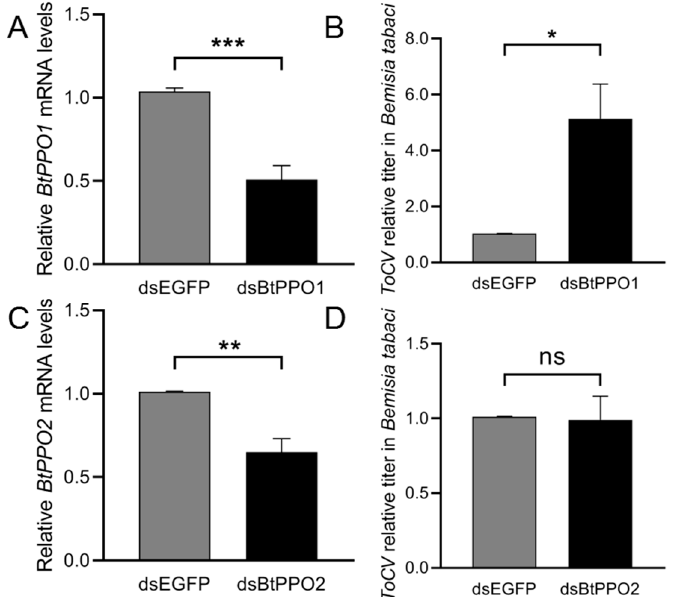
Figure 6. Efficiency of RNA interference and ToCV titer in Bemisia tabaci after RNA interference. ( A ) Relative mRNA levels of BtPPO1 in B. tabaci adults after feeding on a diet containing dsEGFP and dsBtPPO1. ( B ) Effect of BtPPO1 gene silencing on ToCV titer in B. tabaci . Data of ( A , B ) presented as the mean ± SE for nine independent replicates. ( C ) Relative mRNA levels of BtPPO2 in B. tabaci adults after feeding on a diet containing dsEGFP and dsBtPPO2. ( D ) Effect of BtPPO2 gene silencing on ToCV titer in B. tabaci . Data of ( C , D ) presented as the mean ± SE for six independent replicates. The data were normalized to the expression of SDHA and EF-1 α . Asterisks’ indicate significant differences between the treatment and the corresponding untreated control according to the Student’s t ‐ test. * p < 0.05, ** p < 0.01, *** p < 0.001, ns indicates no significant difference.